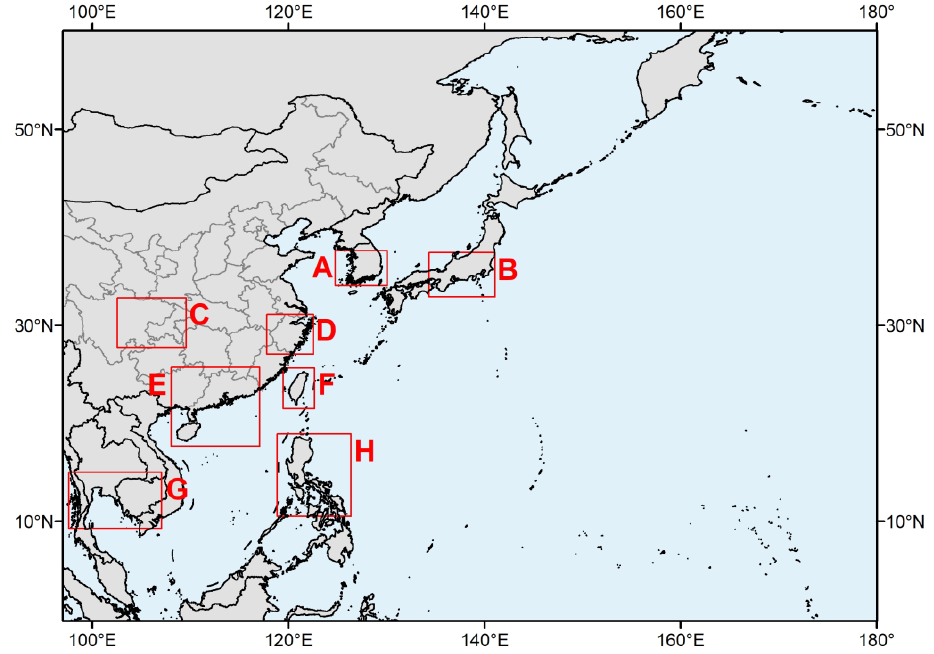
Figure 6. Eight regions of interest in the Northwest Pacific. For tropical cyclone hazard scenario I, the contribution rates of factors in different regions are not consistent. In regions A and G, population exposure is decreasing; mean- while climate change impact is the dominant factor in each period, and shows a slight increasing trend (Figure 7a,g). The decline in tropical cyclone strong wind impact frequency should be the main reason for the decrease in population exposure in regions A and G. In regions D and E, population exposure is increasing; however, population change impact is the dominant factor in each period and shows a slight decreasing trend (Figure